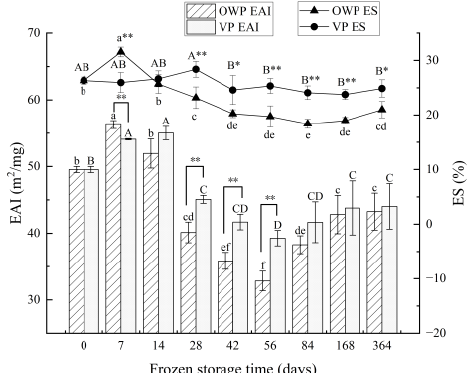
Figure 3. Changes in emulsifying activity index (EAI) and emulsifying stability (ES) of yak rumen SMP during frozen storage. Different superscript letters in the figure indicate significant difference in storage time ( p < 0.05); lowercase letters are for OWP and uppercase letters for VP. “*” indicates that the different packaging is significant ( p < 0.05), “**” indicates that the different packaging is extremely significant ( p < 0.01).